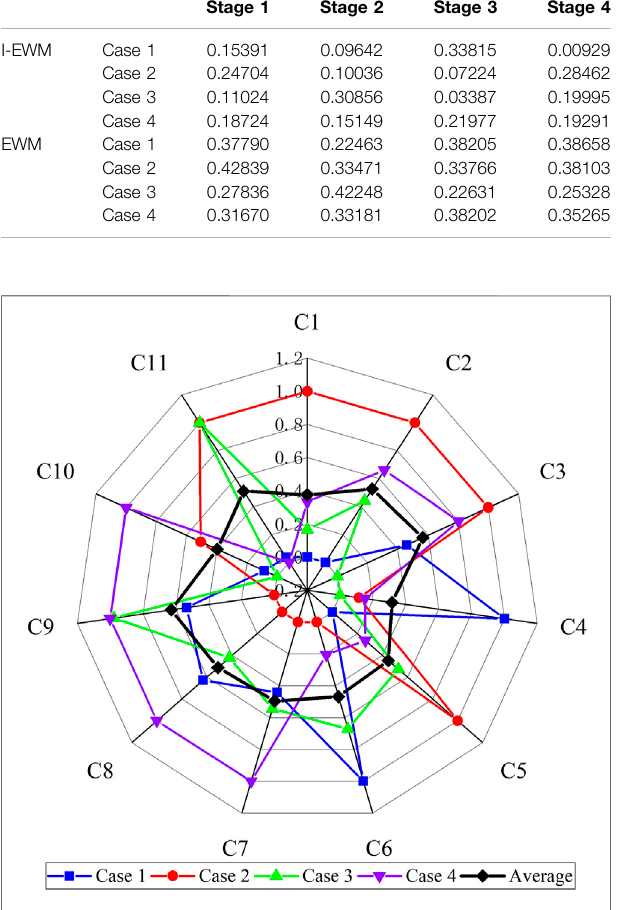
FIGURE 2 | Radar chart of indicators compared to the average for each option under planning stage 1.